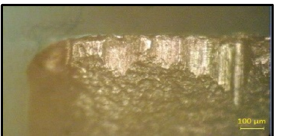
Figure 5: Flank wear after 900 mm cutting by using permanent magnet tool.